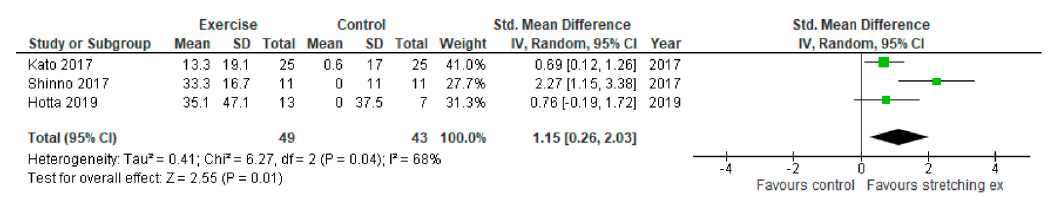
Figure 7. Forest plot comparing changes in endothelial function following stretching exercises to non-exercise controls. SD, standard deviation; IV, inverse variance; CI, confidence interval; Std, standardized.